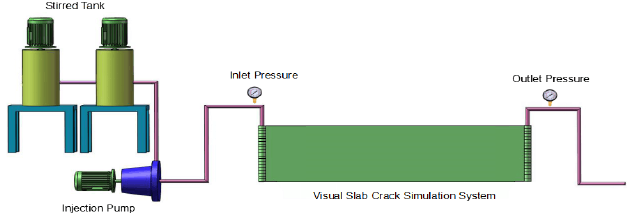
Figure 1. Performance testing device for dynamic sand suspension experimentation.